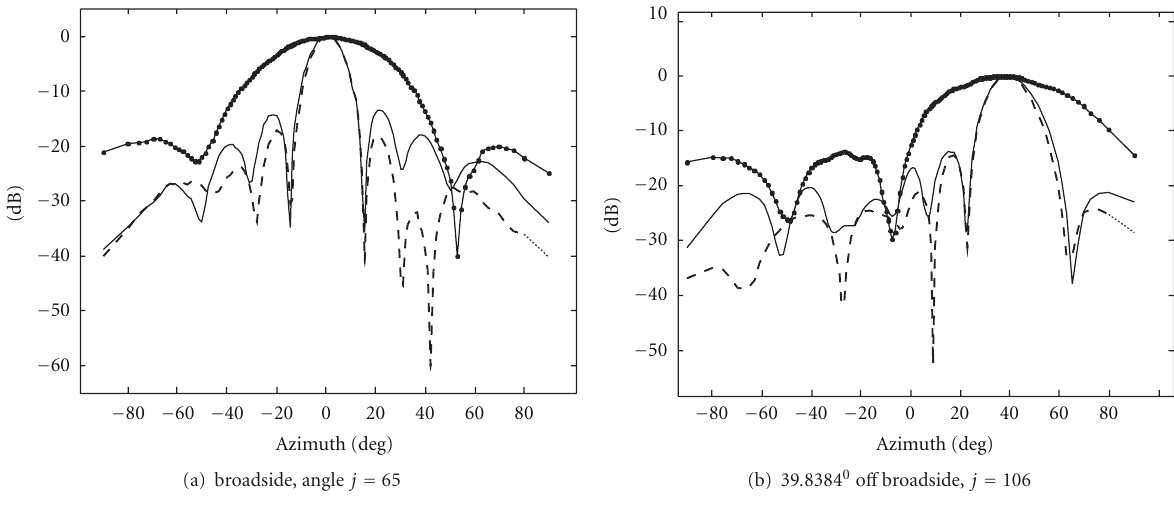
Figure 6: The two receiver patterns and the pattern ratios M = 6 ( − w H A s( φ ), --w H B s( φ ),and • − F ( φ )).